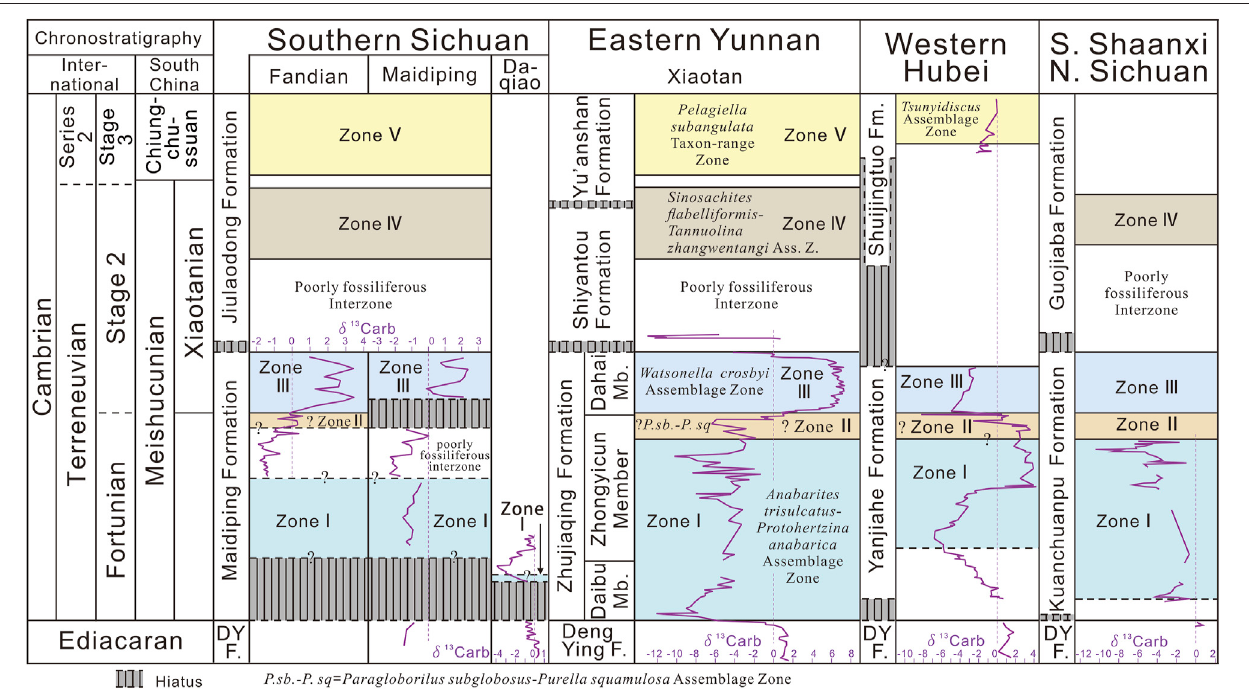
FIGURE 5 | Terreneuvian SSF biozonation of the Fandian section compared with the Maidiping and Daqiao sections in southern Sichuan and other critical regions on the Yangtze Platform (modi fi ed from Steiner et al., 2020; chronostratigraphy of South China referring to Zhu et al., 2019; Steiner et al., 2020). SSF Zone II in western Hubei is according to Guo et al. (2014, 2021). The isotope curve of δ 13 C carb from each section is calibrated based on the SSF biozones. Isotope data of Fandian and DaqiaosectionsfromXiongetal.(2022,inpress;Supplementary fi leherein),ofMaidipingsectionfromYang&Steiner(2021),ofXiaotansectionfromLietal.(2013), of western Hubei from Ishikawa et al. (2008, the Aijiahe/Gunziao section), and of the southern Shaanxi and northern Sichuan from Steiner et al. (2020).